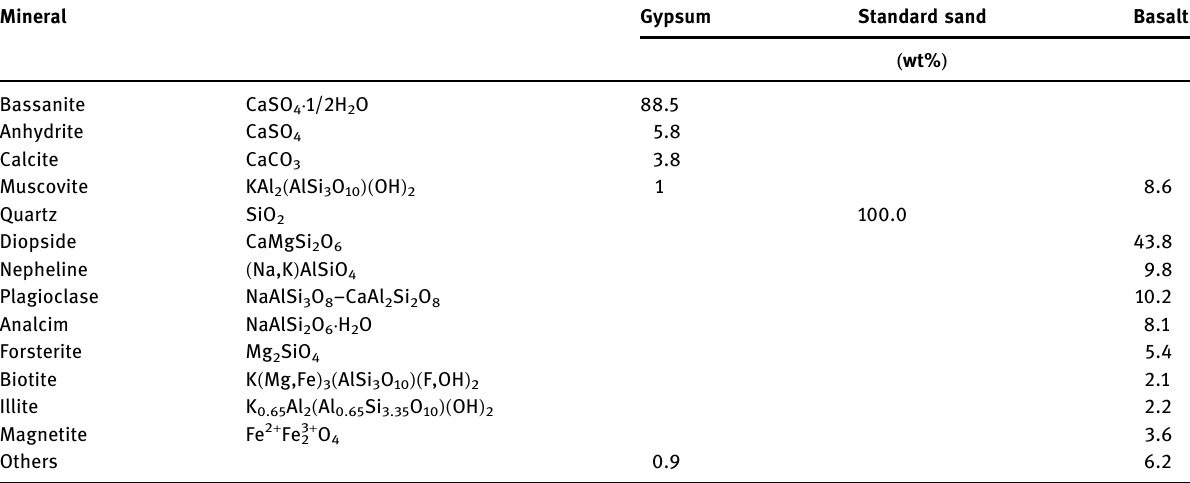
Table 3: Mineral composition of raw materials